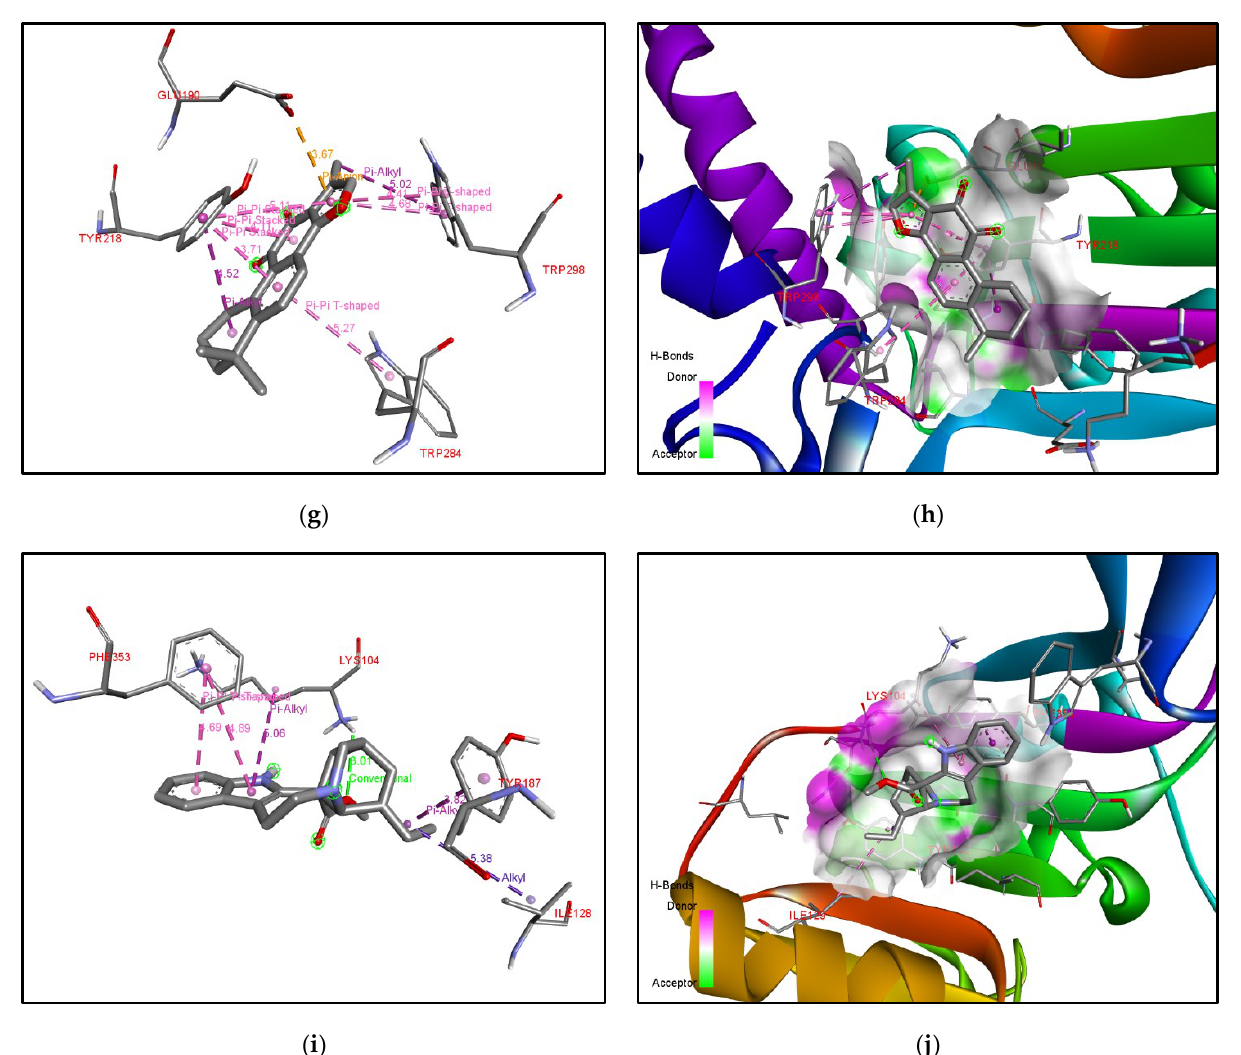
Figure 8. Analysis of docking pocket of XP-SMT: Interactions, bond lengths and hydrogen bond donor and acceptor around ligand binding pocket for XP SMT-ligand interaction are shown in these figures. ( a ) XP-cyclopamine interactions in purple and green. ( b ) XP protein surface at proximity to Cyclopamine colored pink or green based on Hydrogen bond donors or acceptors. ( c ) XP-Chelerythrine interactions in golden yellow, pink, purple. ( d ) XP protein surface at proximity to Chelerythrine colored pink or green based on Hydrogen bond donors or acceptors. ( e ) XP-Berberine interactions in pink and purple. ( f ) XP protein surface at proximity to Berberine colored pink or green based on Hydrogen bond donors or acceptors. ( g ) XP-Tanshinone 2 A interactions in golden yellow, pink and purple. ( h ) XP protein surface at proximity to Tanshinone 2A colored pink or green. ( i ) XP-Catharanthine interactions in pink, purple-blue, green, pink, and blue. ( j ) XP protein surface at proximity to Catharanthine colored pink or green based on hydrogen bond donors or acceptors.